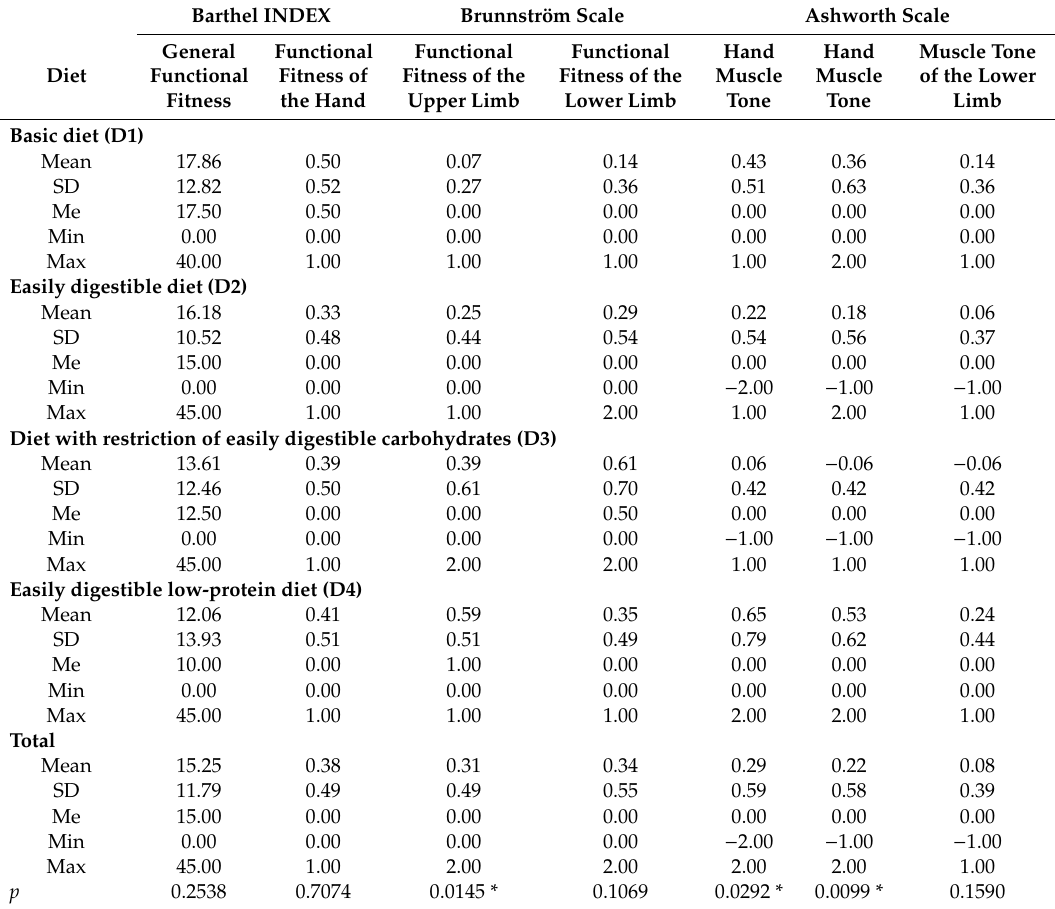
Table 4. Type of diet and functional fitness after a four-month observation of stroke